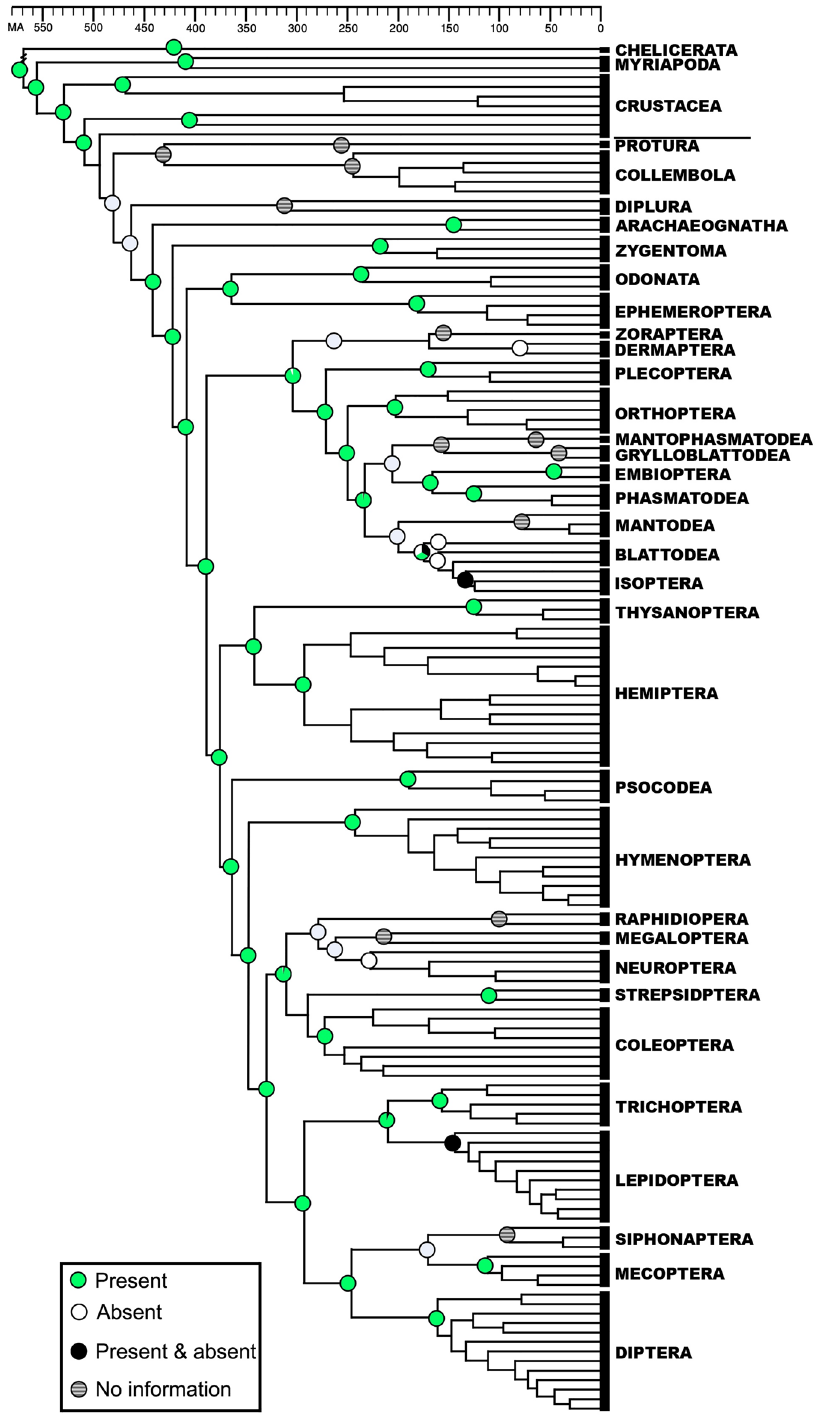
Figure 1. Ancestral state reconstruction of the ability to synthesize isopentenyladenine (iP) and isopentenyladenosine (iPR) in terrestrial arthropods. Circles in nodes represent the percentage of the probability of the reconstructed character state. The time-calibrated phylogenetic tree is modified from (3). Time Scale is in millions of years before